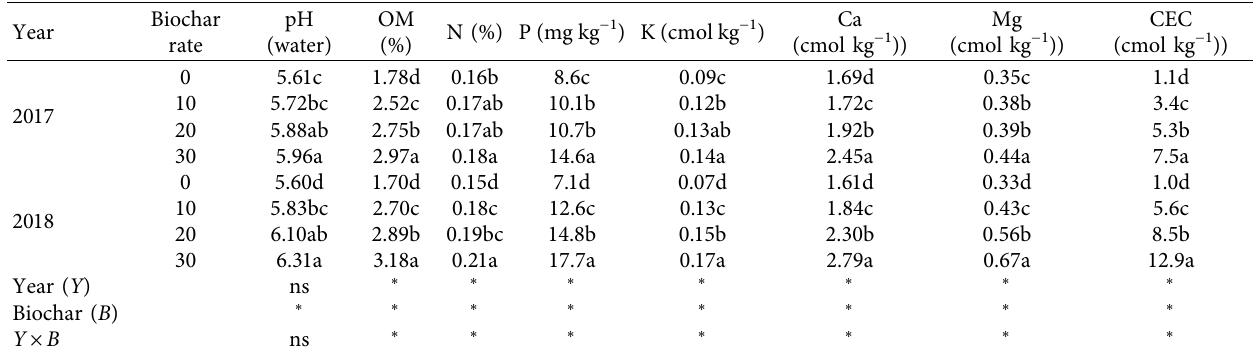
Table 3: Effect of biochar on soil chemical properties in 2017 and 2018.